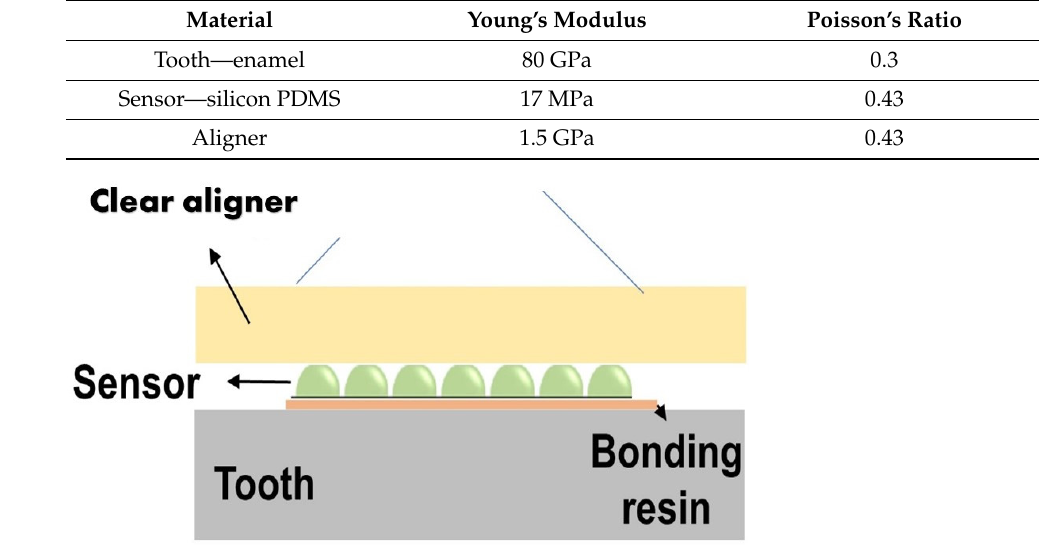
Figure 2. Proposed sensor system architecture.